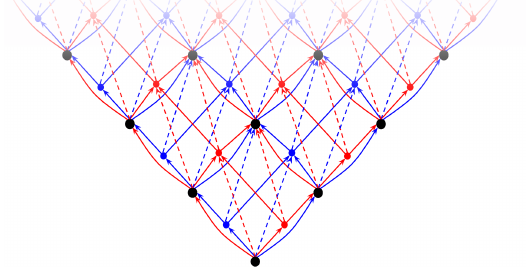
Figure 3. Part of the graph formed by the repeated application of Rule 2. F is shown in red, F (cid:48) is shown in blue, and their shared vertices are shown in black. The solid arrows represent light-like edges while the dashed arrows represent time-like